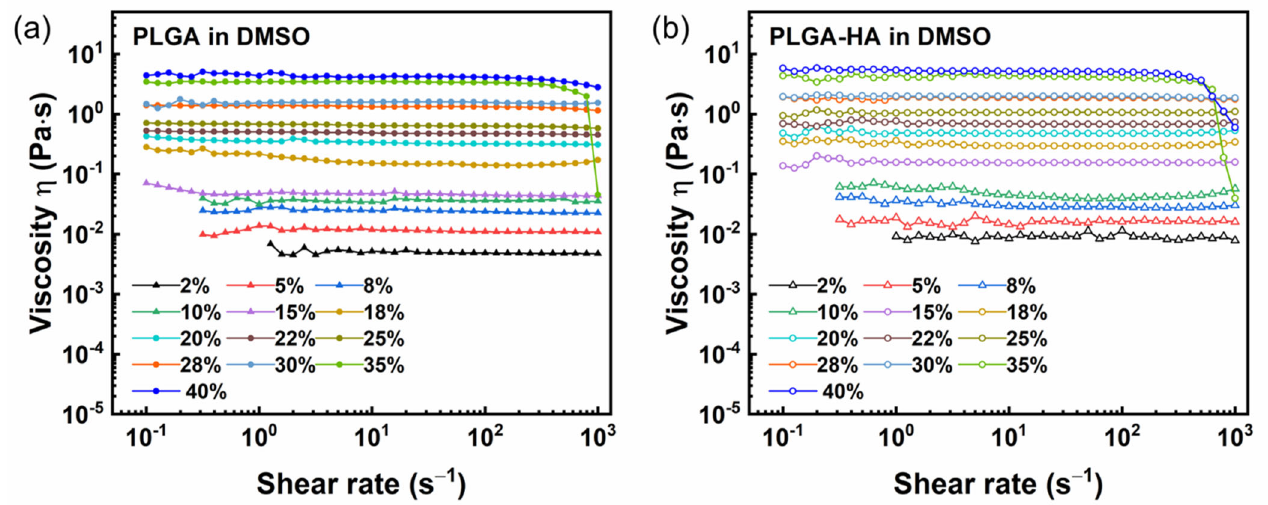
Figure 1. Dependence of solution viscosity on shear rate for ( a ) PLGA in DMSO solutions and ( b ) PLGA ‐ 1.5% HA in DMSO solutions.